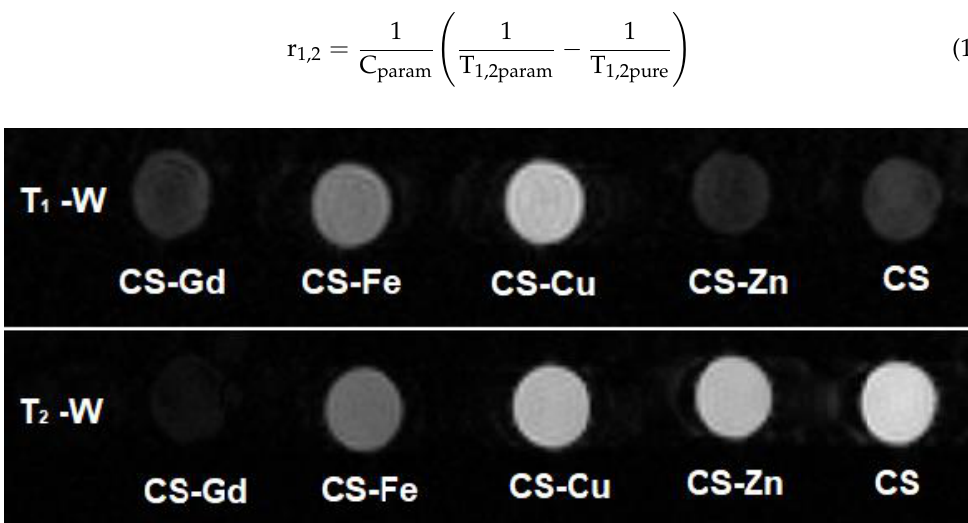
Figure 6. T 1 -weighted ( top ) and T 2 -weighted ( bottom ) MR images of CS–metal and CS microgel water dispersions obtained with 0.5 T MRI scanner. (T 1 -weighted image IR sequence parameters: TR = 5000 ms, TE = 20 ms, TI = 1000 ms; T 2 -weighted image SE sequence parameters: TR = 5000 ms, TE = 26